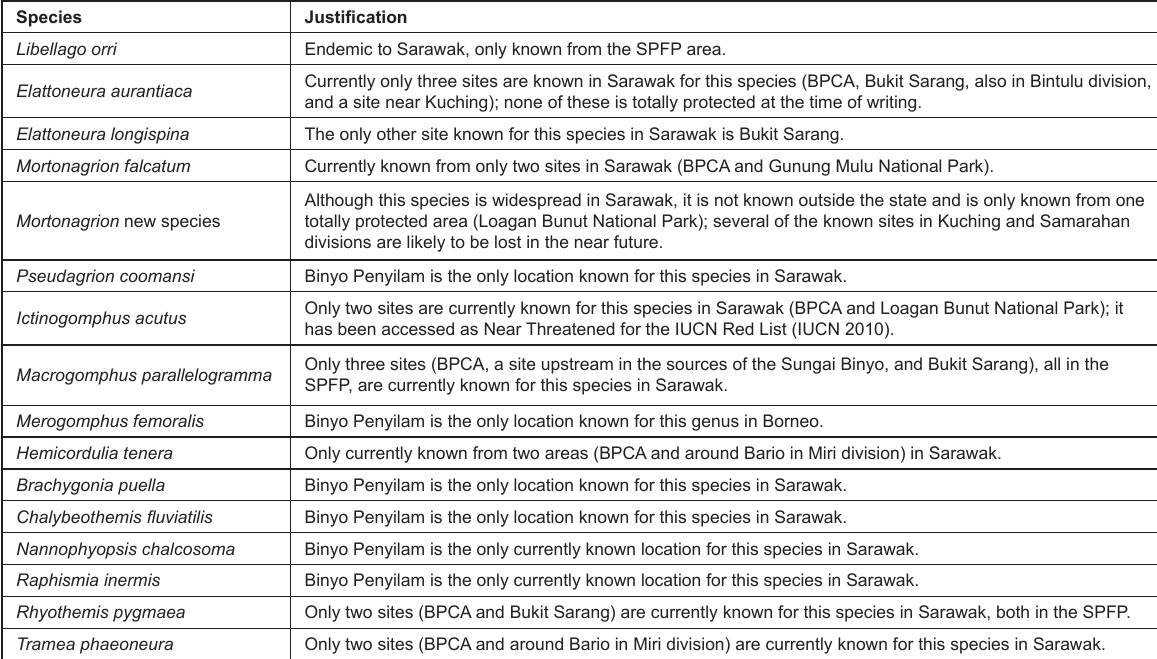
Table 1. Odonata species recorded from Binyo Penyilam and potentially of conservation